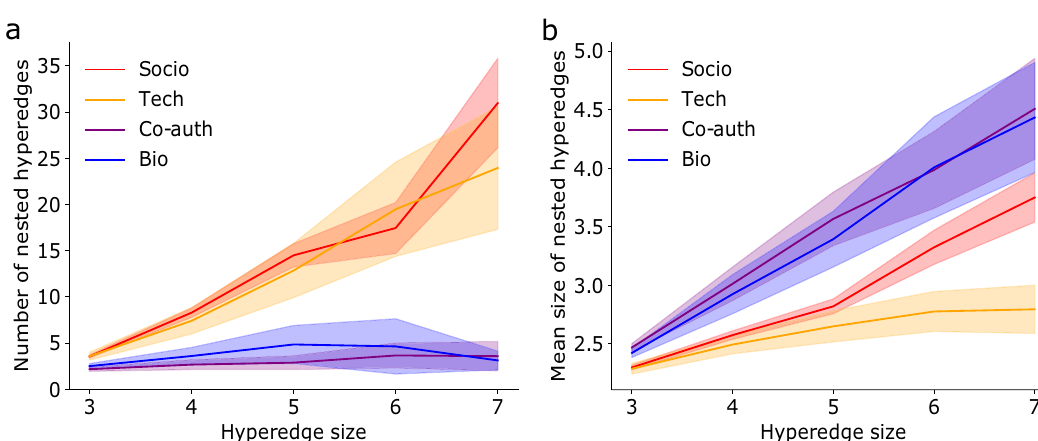
Fig. 4 Nested organization of group interactions. Different higher-order families of hypergraphs can display very different hierarchical organization of their higher-order interactions. a Mean number of hyperedges in the nested structure of large hyperedges as a function of their size. Biological and co- authorship networks display a static behavior, while social and technological networks show a clear increasing richness of the nested hierarchical structures of the hyperedges. b Mean average size of the hyperedges in the nested structure of large hyperedges as a function of their size. All the domains show a linear growing trend; however, biological and co-authorship networks grow faster. All in all, Socio/Tech networks tend to have a lot of small-size edges in the nested structure of their hyperedges. The Bio/Co-auth domain, instead, tend to prefer few large-size edges. In both panels, the shaded area represents the standard deviation.